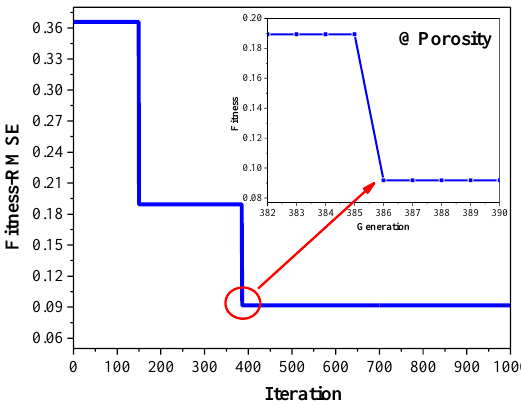
Figure 11. Fitness (RMSE) evolution curve of the porosity.